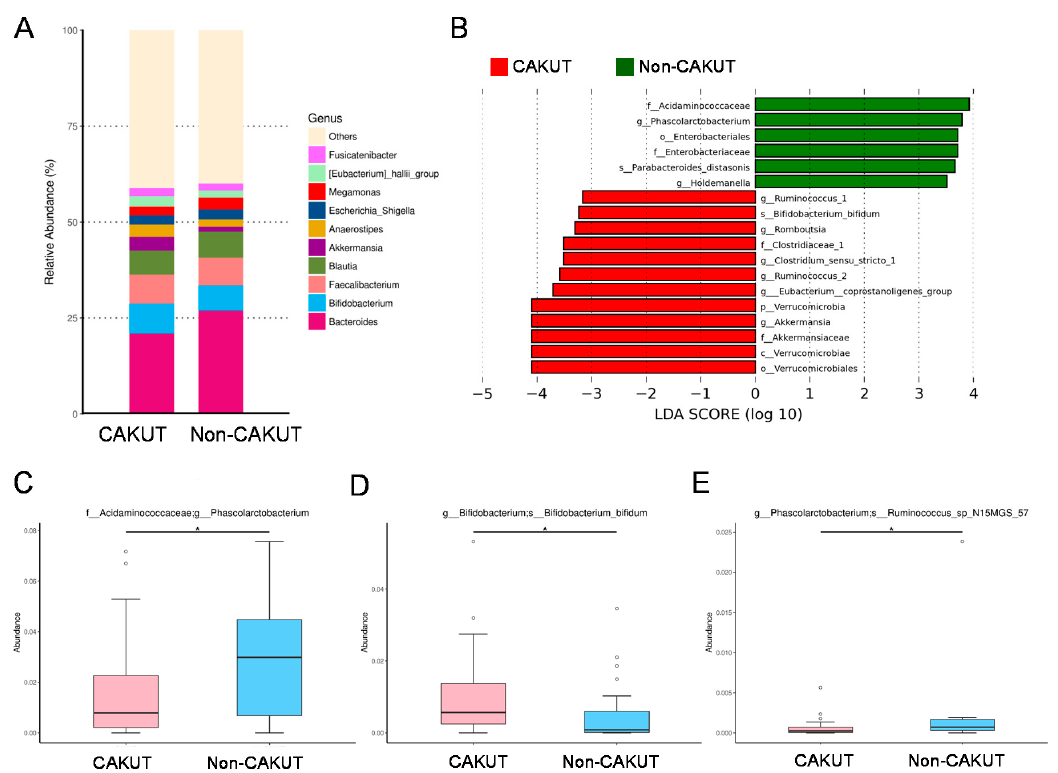
Figure 2. ( A ) Relative abundance of the top 10 genera of the gut microbiota between the CAKUT and non-CAKUT group. ( B ) Linear discriminant analysis effect size (LEfSe) to identify the taxa that were significantly different between the CAKUT and non-CAKUT group. The threshold of the linear discriminant was set to 3. ( C ) The abundance of genus Phascolarctobacterium , ( D ) species Bifidobacterium bifidum , and ( E ) species Ruminococcus_sp_N15MGS_57 in CKD children with CAKUT vs. non-CAKUT. The asterisk indicates p < 0.05.